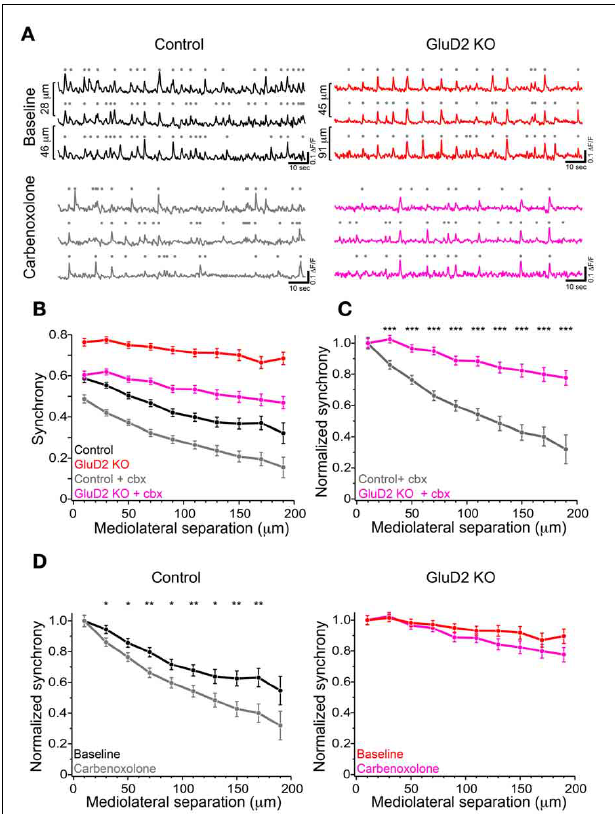
FIGURE 4 | Carbenoxolone reduced the synchrony but little altered the degree of decline along the mediolateral axis in GluD2 KO mice. (A) Three representative traces of calcium transient from neighboring PC dendrites before (baseline) and ∼ 1h after carbenoxolone injection (carbenoxolone), obtained from control (left) and GluD2 KO (right) mice. Distances of mediolateral separation between dendrites are indicated on the left of the traces. In both genotypes, synchronous calcium transients were apparently reduced in frequency by carbenoxolone. (B) Summary graph showing pooled data of synchrony for 318 dendrite pairs obtained from 8 control mice and for 267 dendrite pairs from 5 GluD2 KO mice. Carbenoxolone (cbx) injection reduced mean values of synchrony in both genotypes. It should be noted that the difference between the genotypes was highly significant after carbenoxolone injection [control + cbx (gray) vs. GluD2 KO + cbx (magenda), p < 0 . 001 by Two-Way ANOVA], as was before drug application (control (black) vs. GluD2 KO (red), p < 0 . 001 by Two-Way ANOVA). (C) Normalized synchrony curves of control and GluD2 KO mice after carbenoxolone injection. The rate of decline against the mediolateral separation was significantly smaller in GluD2 KO mice than that in control mice ( ∗∗∗ p < 0 . 001 by Two-Way ANOVA and Tukey test). (D) Normalized synchrony curves before and after carbenoxolone injection plotted for control (left graph) and GluD2 KO (right graph) mice. In control mice, synchrony was significantly decreased by carbenoxolone at all but the nearest and the farthest points of separation, whereas in GluD2 KO mice, significant differences were not detected at all points of mediolateral separation points ( ∗ p < 0 . 05, ∗∗ p < 0 . 01 by Two-Way ANOVA and Tukey test).